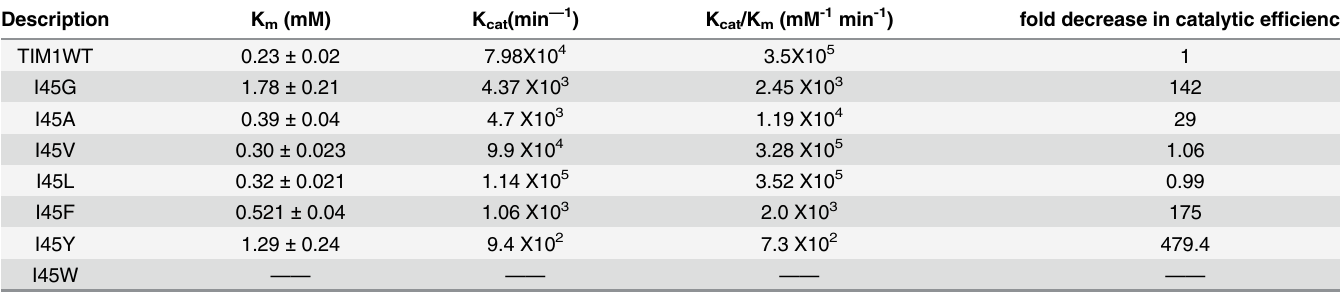
Table 1. Catalytic parameters of ball and socket TvTIM mutants.